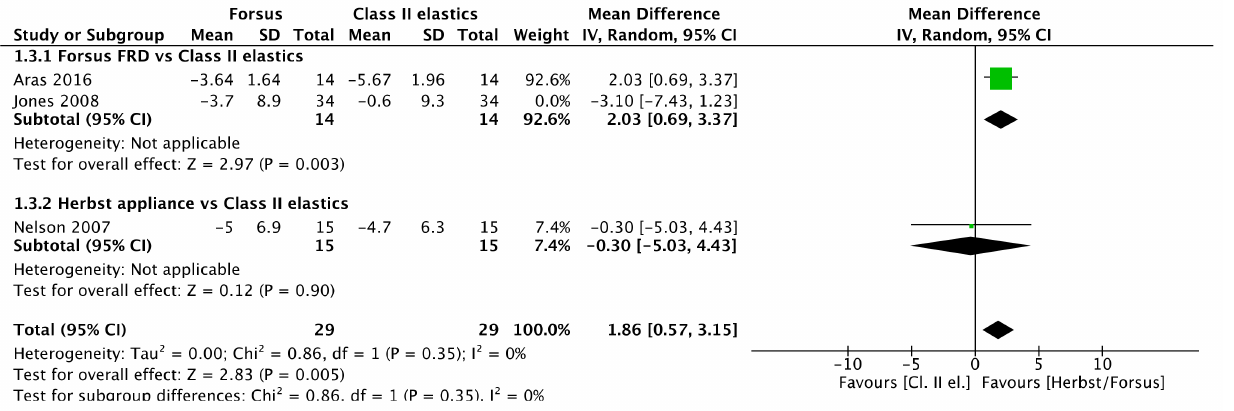
Figure 26. Forest plot of the sensitivity analysis on upper incisor inclination changes using the random effects model